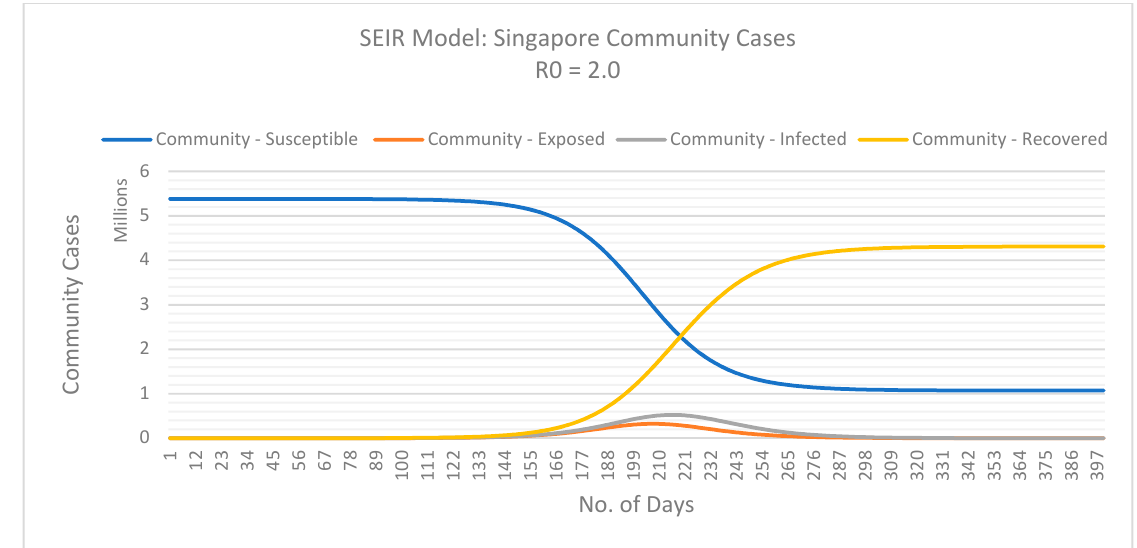
Figure 6. Predicted dynamics of the COVID-19 outbreak within Singapore’s local community not living in dormitories. Basic reproduction numbers ( R 0) is 2.0. Data retrieved from the Singapore Ministry of Health and the WHO [68,69]. Last